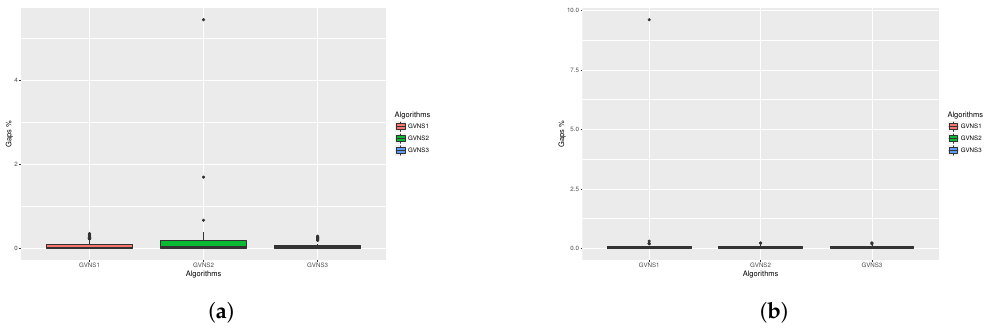
Figure 3. Statistical test for sTSP (1/2). ( a ) Statistical test box plots for sTSP 1min FI; ( b ) Statistical test box plots for sTSP 1min BI.